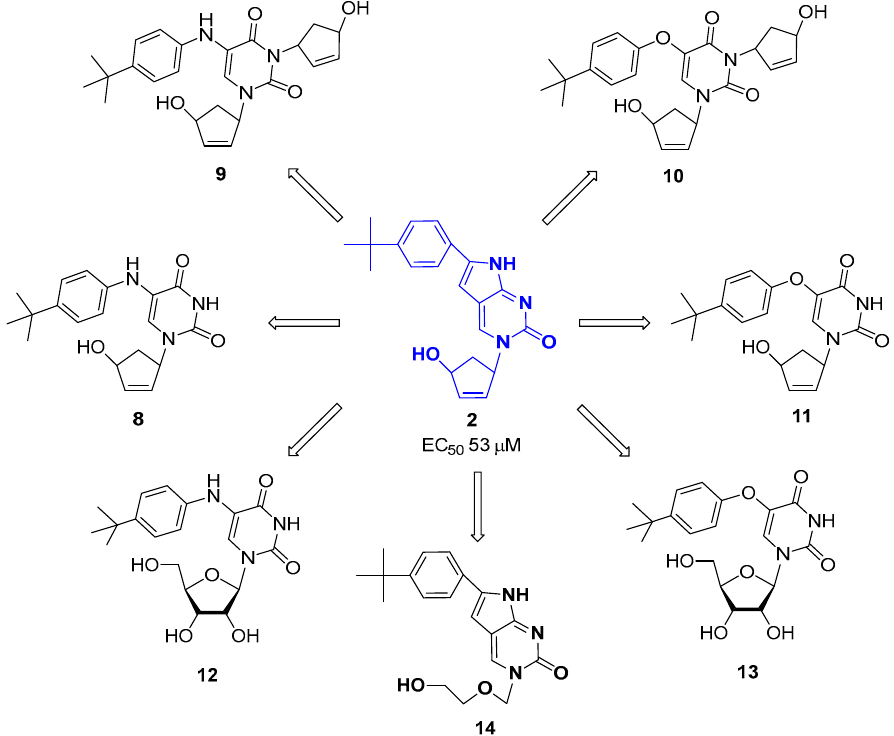
Figure 2. Directions of 1-(4’-hydroxy-2’-cyclopenten-1-yl)-6-(4-tert-butylphenyl)-3H-pyrrolo [2,3-d]-pyrimidine-2-one (compound 2 ) modification.